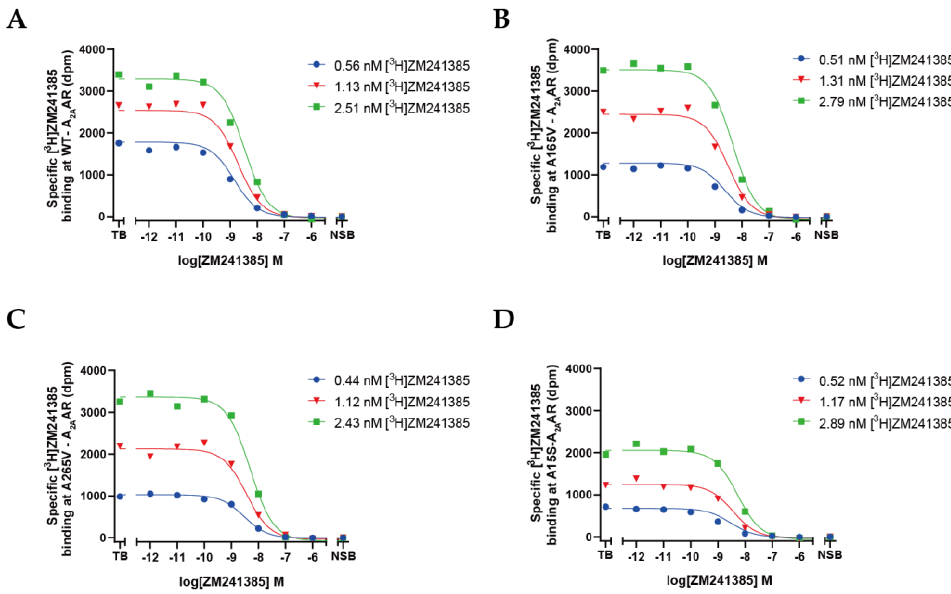
Figure 3. Homologous displacement of three concentrations of [ 3 H]ZM241385 performed by increasing the concentrations of ZM241385 in WT-A 2A AR ( A ), A165V-A 2A AR ( B ), A265V-A 2A AR ( C ), and A15S-A 2A AR ( D ). Note that different concentrations of membranes were used depending on receptor expression levels, i.e., WT-A 2A AR (1 μ g), A165V-A 2A AR ( 3 μg ), A265V-A 2A AR ( 1.5 μg ), and A15S-A 2A AR ( 3 μg ). Three independent experiments were performed in duplicate, and representative curves from one experiment are shown above. Compared with WT-A 2A AR, A165V and A265V displayed different affinity for ZM241385, and A15S displayed similar affinity but different B max . Graphs for other mutants can be found in Figure S1. Table 1. Affinity values of ligands for wild-type (WT) and mutant A 2A ARs and their expression levels (B max ).